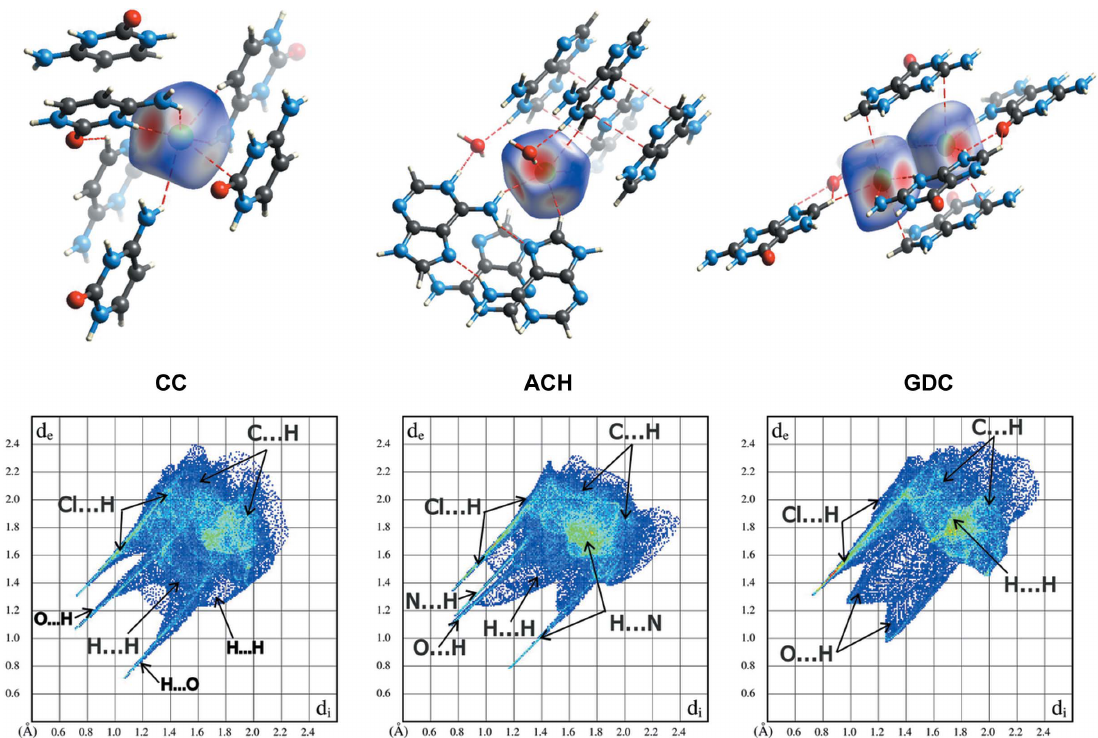
Figure 5 (Top) d norm mapped on a Hirshfeld surface of the chloride anions to visualize the contacts with surrounding molecules, and (bottom) fingerprint plots of the nucleobase cations, in (left) CC, (middle) ACH and (right) GDC